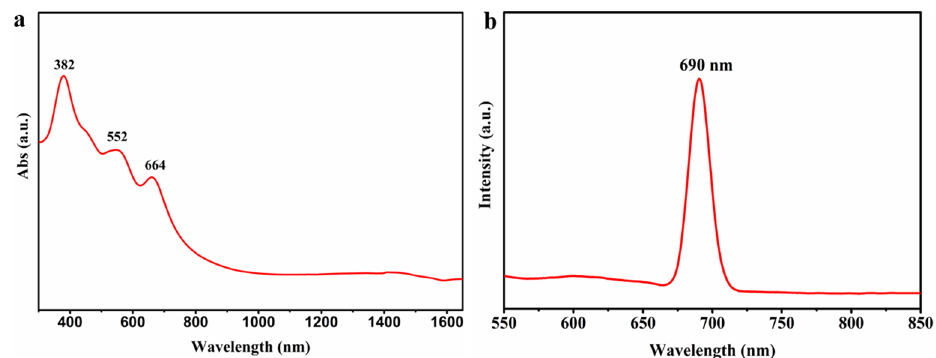
Figure 7. ( a ) UV–Vis–NIR spectrum. ( b ) Photoluminescence (PL) spectrum of the synthesized Cu 3 VSe 4 NSs in